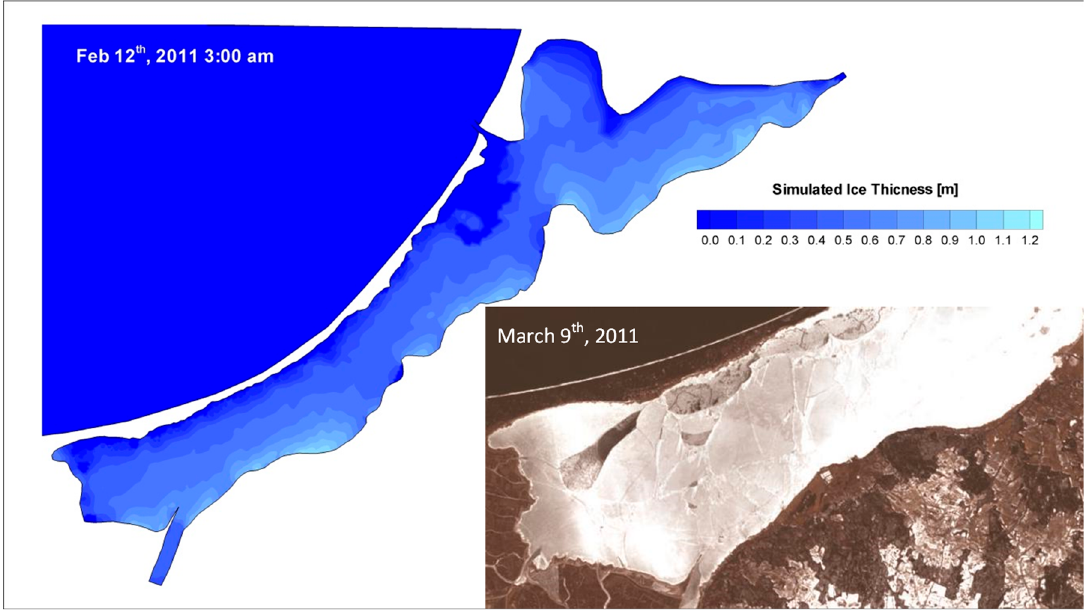
Figure 8. Simulated ice thickness on 12 February 2011 and a satellite image of the southern part of the Vistula Lagoon (Landsat 5, 9 March 2011; https://eos.com/landviewer/).